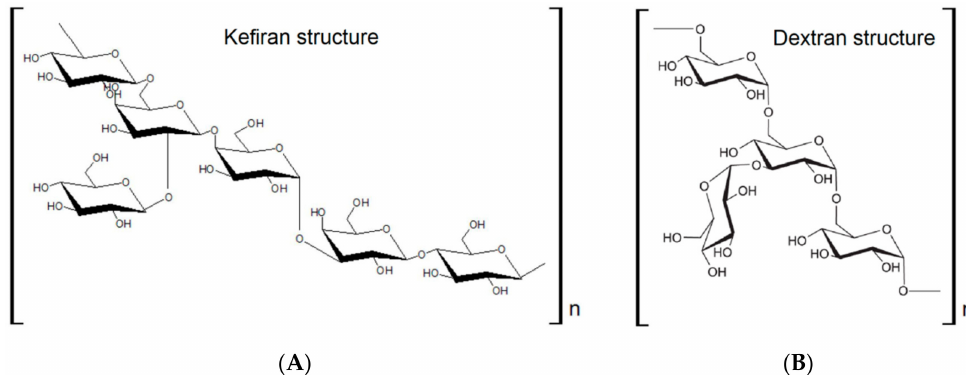
Figure 3. Chemical structure of kefiran ( A ) and dextran ( B )